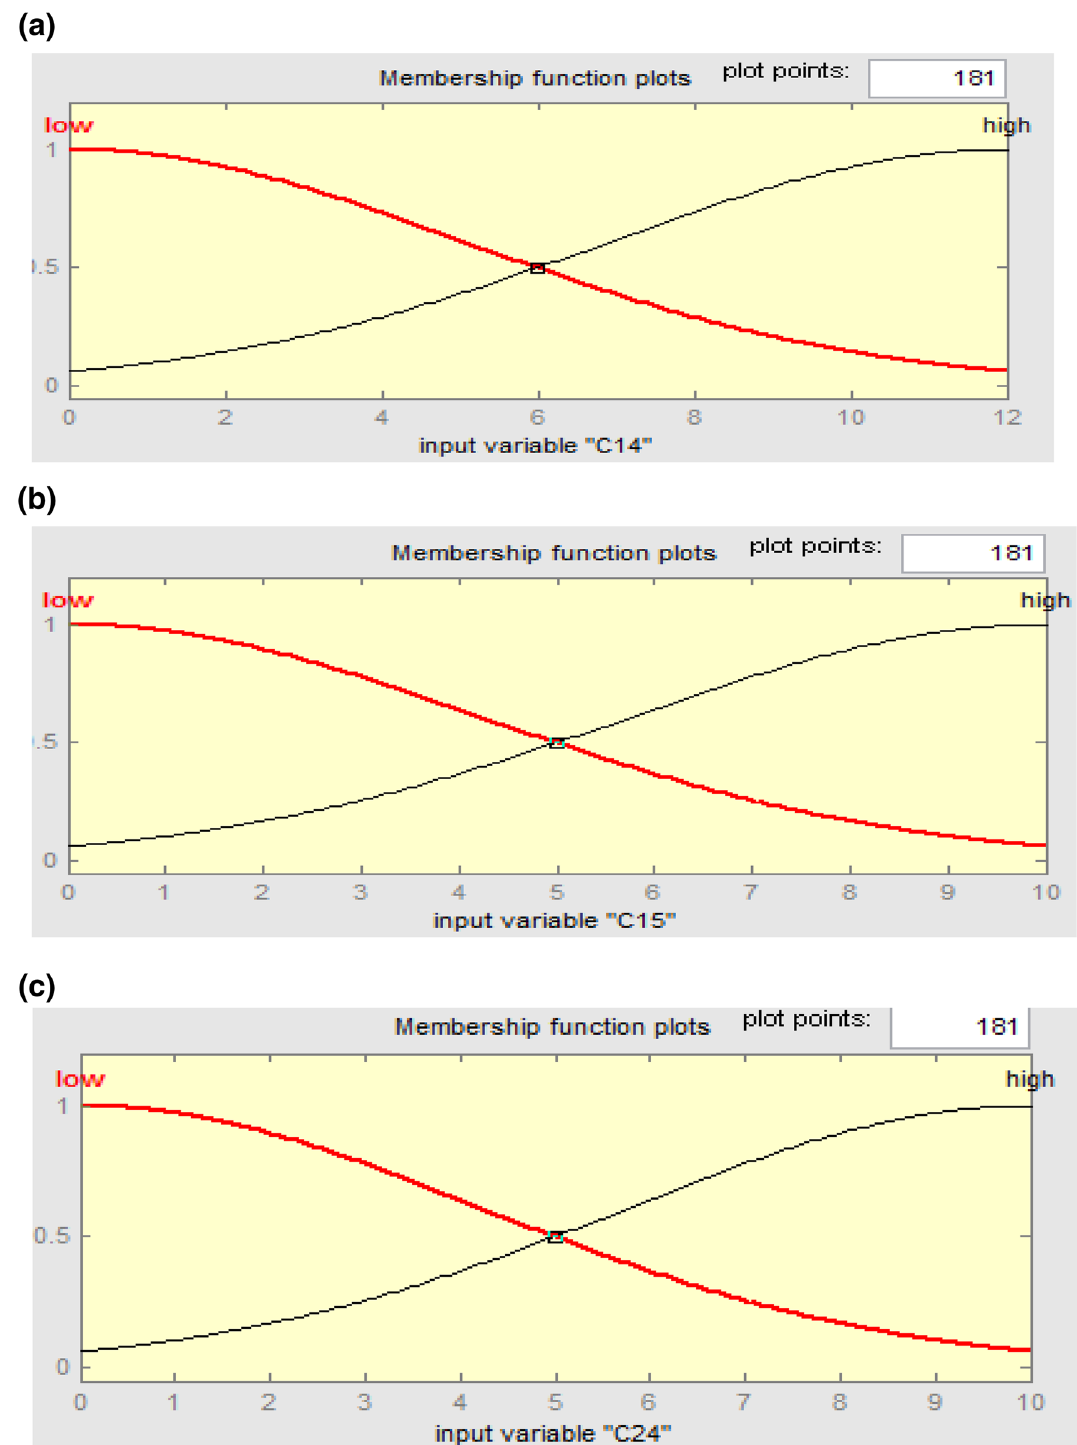
Fig. 3 a – f Membership function plot for input